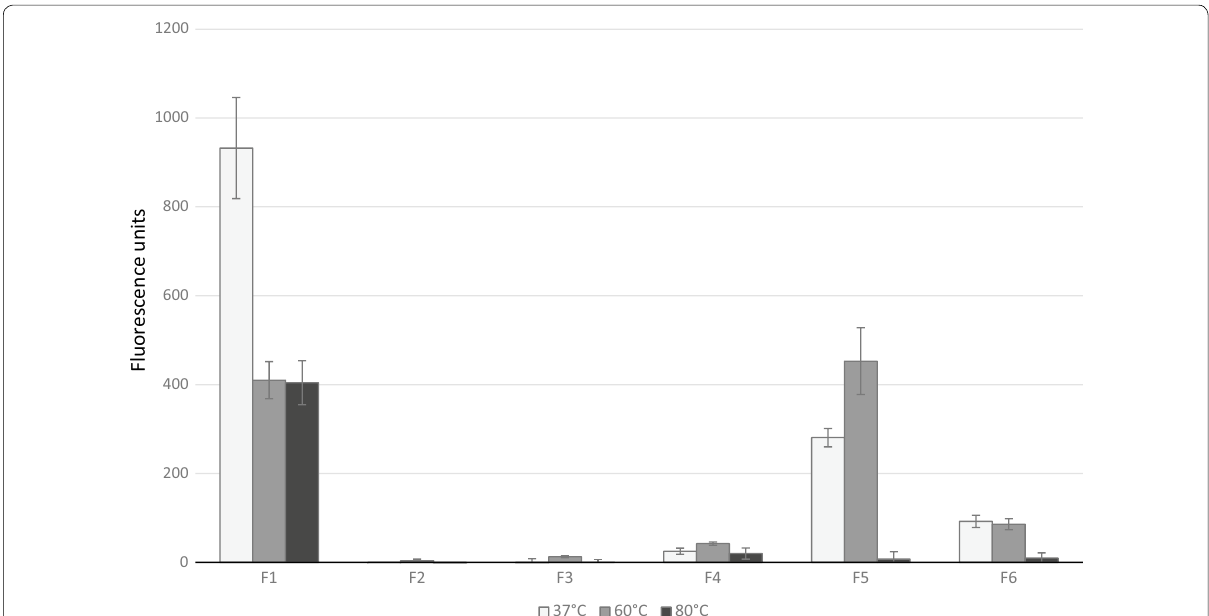
Fig. 2 Quantitative MUC assay for six fosmid clones that were identified using a functional assay with the CMB substrate. The activity is reported as units of fluorescent signal intensity. Supernatants of the six clones were incubated at 37 °C (light grey), 60 °C (medium dark grey) or 80 °C (dark grey) to test the thermal stability of each cellulase. Error bars represent standard deviations from three independent measurements